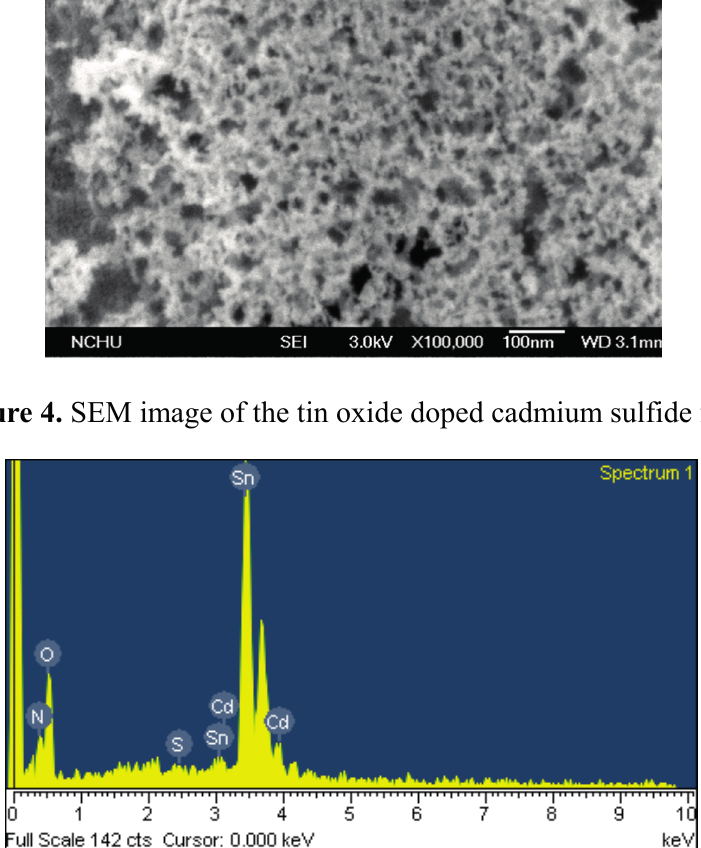
Figure 5. EDS analysis of tin oxide doped cadmium